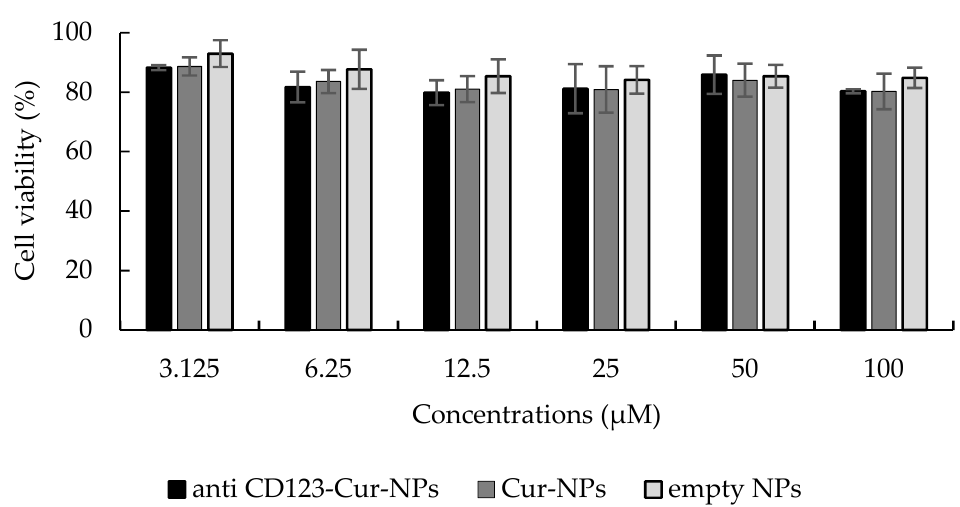
Figure 6. Cytotoxicity of NPs to peripheral blood mononuclear cells (PBMCs). PBMCs were treated with anti-CD123-Cur-NPs, Cur-NPs, and empty NPs for 48 h. The MTT assay determined the cell viability. Each bar represents the mean ± SD of three independent experiments performed in triplicate.